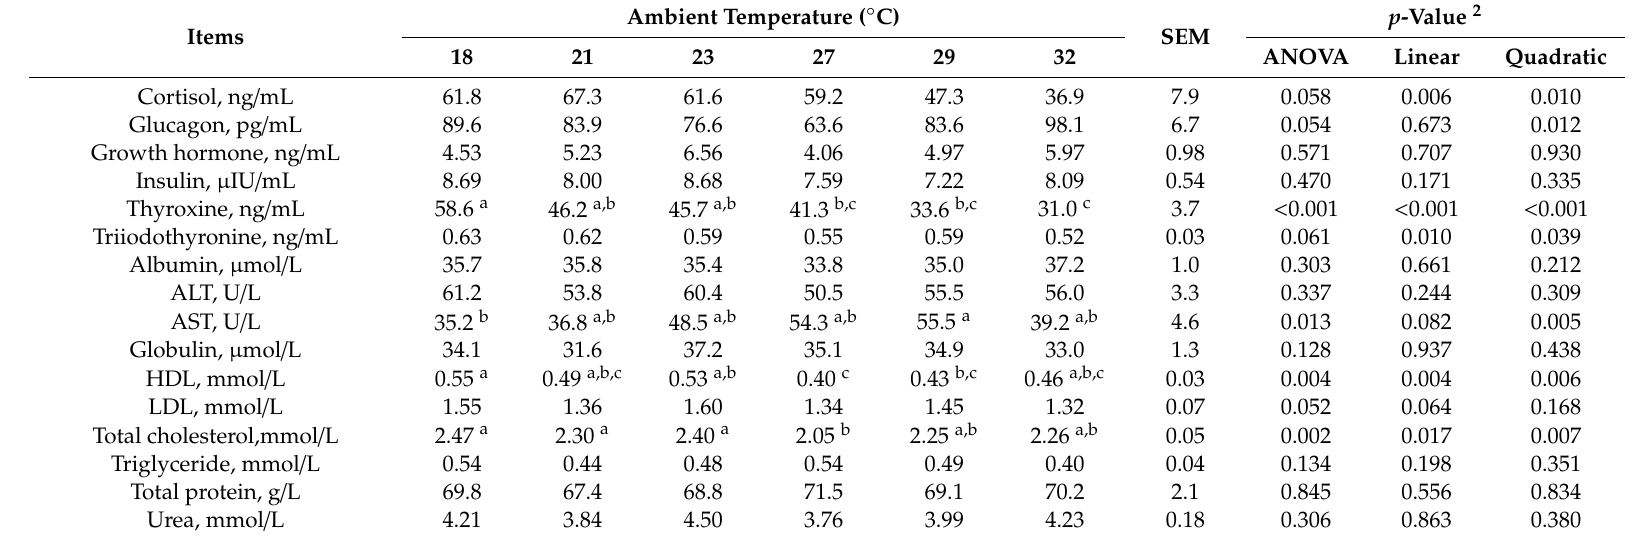
Table 5. Hormone and biochemical markers levels in serum of barrows at 25 kg kept at di ff erent ambient temperature 1